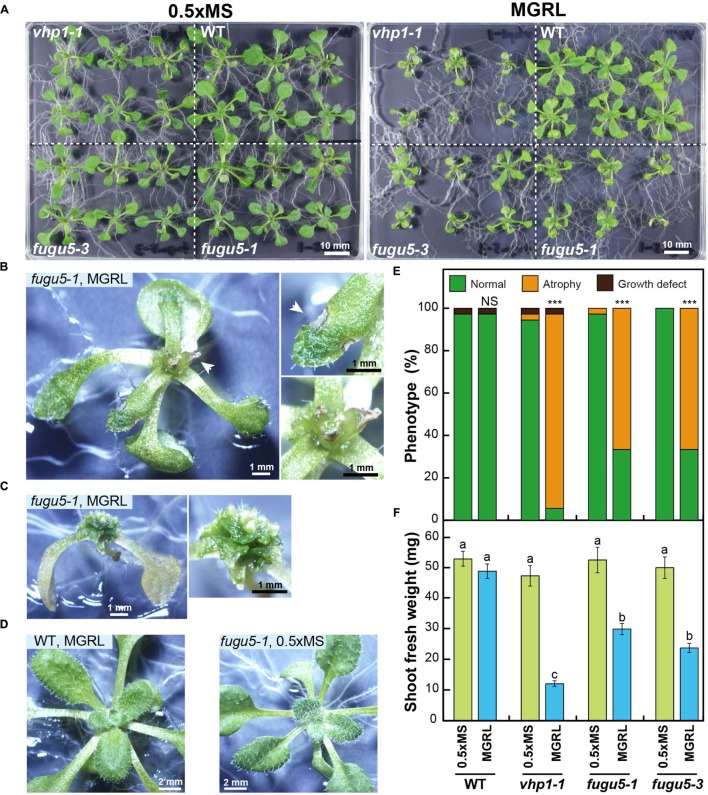
Leaf atrophy occurs in fugu5 mutants grown on MGRL culture medium.
(A) The H+-PPase loss-of-function mutants (fugu5-1, fugu5-3, and vhp1-1) were grown on MS or MGRL plates for 16 days and photographed. (B-E) Enlarged images of fugu5-1 and WT plants taken by a stereoscopic microscope. (B)
fugu5-1 grown on an MGRL plate (left). Rosette leaf (right, upper) and a shoot top (right, lower) showing atrophy (arrowheads). (C) Severe atrophy of the leaf and shoot of fugu5-1 grown on an MGRL plate. (D) WT grown on an MGRL plate. (E)
fugu5-1 grown on an MS plate. (F, upper graph) WT and mutant plants were phenotypically sub-classified into three groups: normal plants (green), plants with leaf atrophy (dark yellow), and plants with growth defects (dark brown). The frequencies of these phenotypes are shown (n = 36). Asterisks indicate significant differences in the proportion of atrophied plants between MS and MGRL plates at ∗∗∗P < 0.001 [prop.test; R ver. 3.1.2 (R Core Team, 2014)]. NS, not significant. (F, lower graph) Shoot fresh weight. Letters indicate groups divided by Tukey’s honest significant difference test [R ver. 3.1.2 (R Core Team, 2014)]. Error bars show SEs.